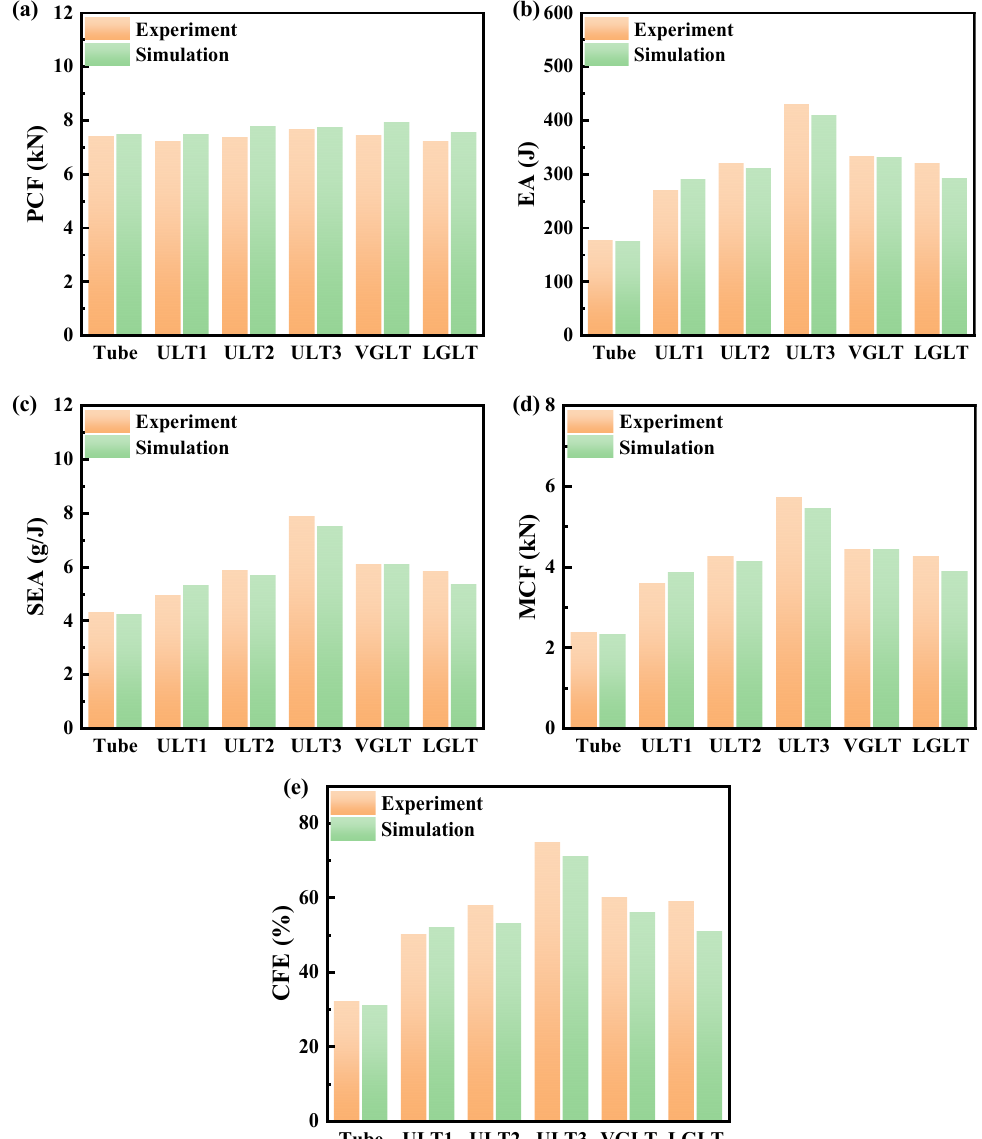
Figure 12. Bar charts of crashworthiness indexes for empty and hybrid tubes ( a ) PCF; ( b ) EA; ( c ) SEA; ( d ) MCF; and ( e ) CFE.